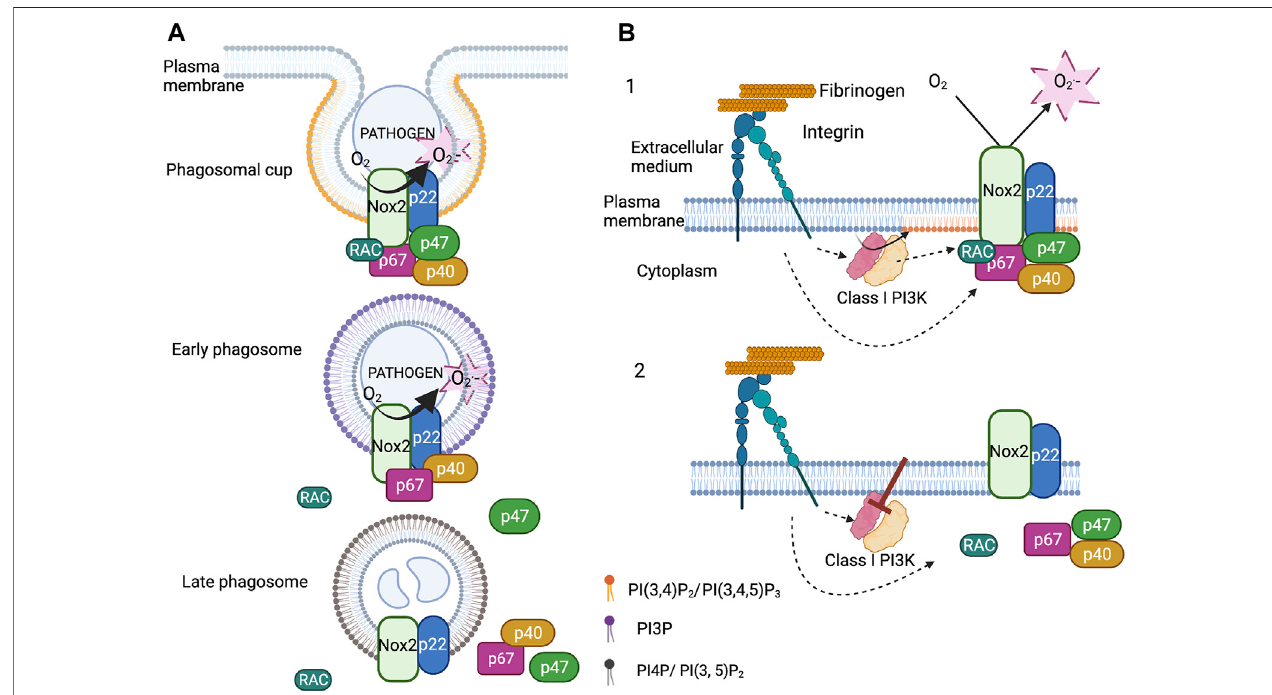
FIGURE2| Regulation oftheNADPHoxidase byphosphoinositides. (A) .Uponphagocytosis ofserum opsonizedfungusparticles, PI(3,4)P 2 and PIP 3 accumulate intheinnerlea fl etofthephagosomalmembrane.Atthesametime,thecytosolicsubunits(p67 phox ,p47 phox andp40 phox )andthesmallGTPasesRac2associatewiththe membrane subunits (Nox2 and p22 phox ). Soon after phagosome closure, p47 phox and Rac2 leave the phagosome. The detachment of p47 phox is concomitant to the decrease in the level of PI(3,4)P 2 and the accumulation of PI3P in the cytosolic lea fl et of the early phagosome. The binding of p40 phox to PI3P sustains the NADPH oxidase activity. The disappearance of PI3P induces the disassembly of the complex. (B) . Integrin dependent adherent neutrophils, stimulated or not by fMLP, produce ROS via NADPH oxidase activation. Class I PI3Ks are also activated and are necessary to sustain NADPH oxidase activation. Inhibition of Class I PI3Ks, especially the β isoform,deactivatetheNADPHoxidasebytriggeringitsdisassembly.ClassIPI3KproductsmaintainthecytosolicsubunitsattheplasmamembraneprobablyviathePX domain of p47 phox ( created with “ BioRender.com ”